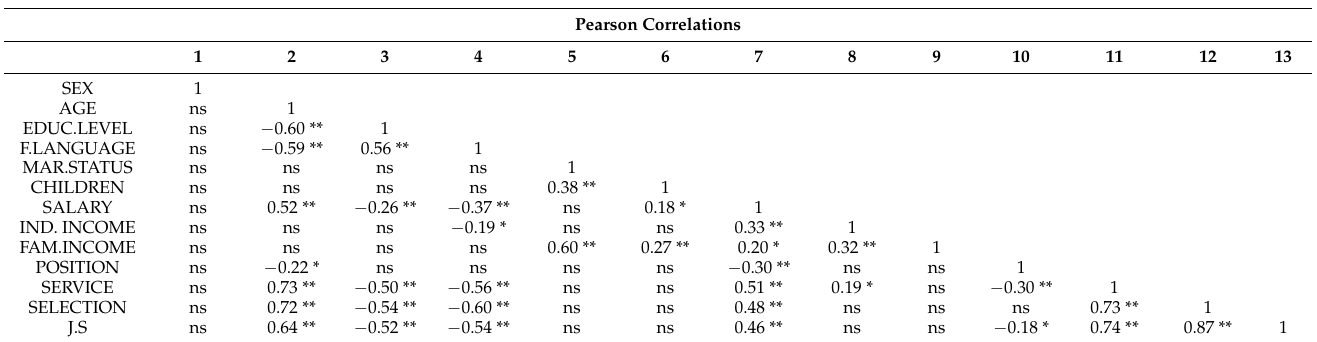
Table 4. Pearson correlations. Pearson